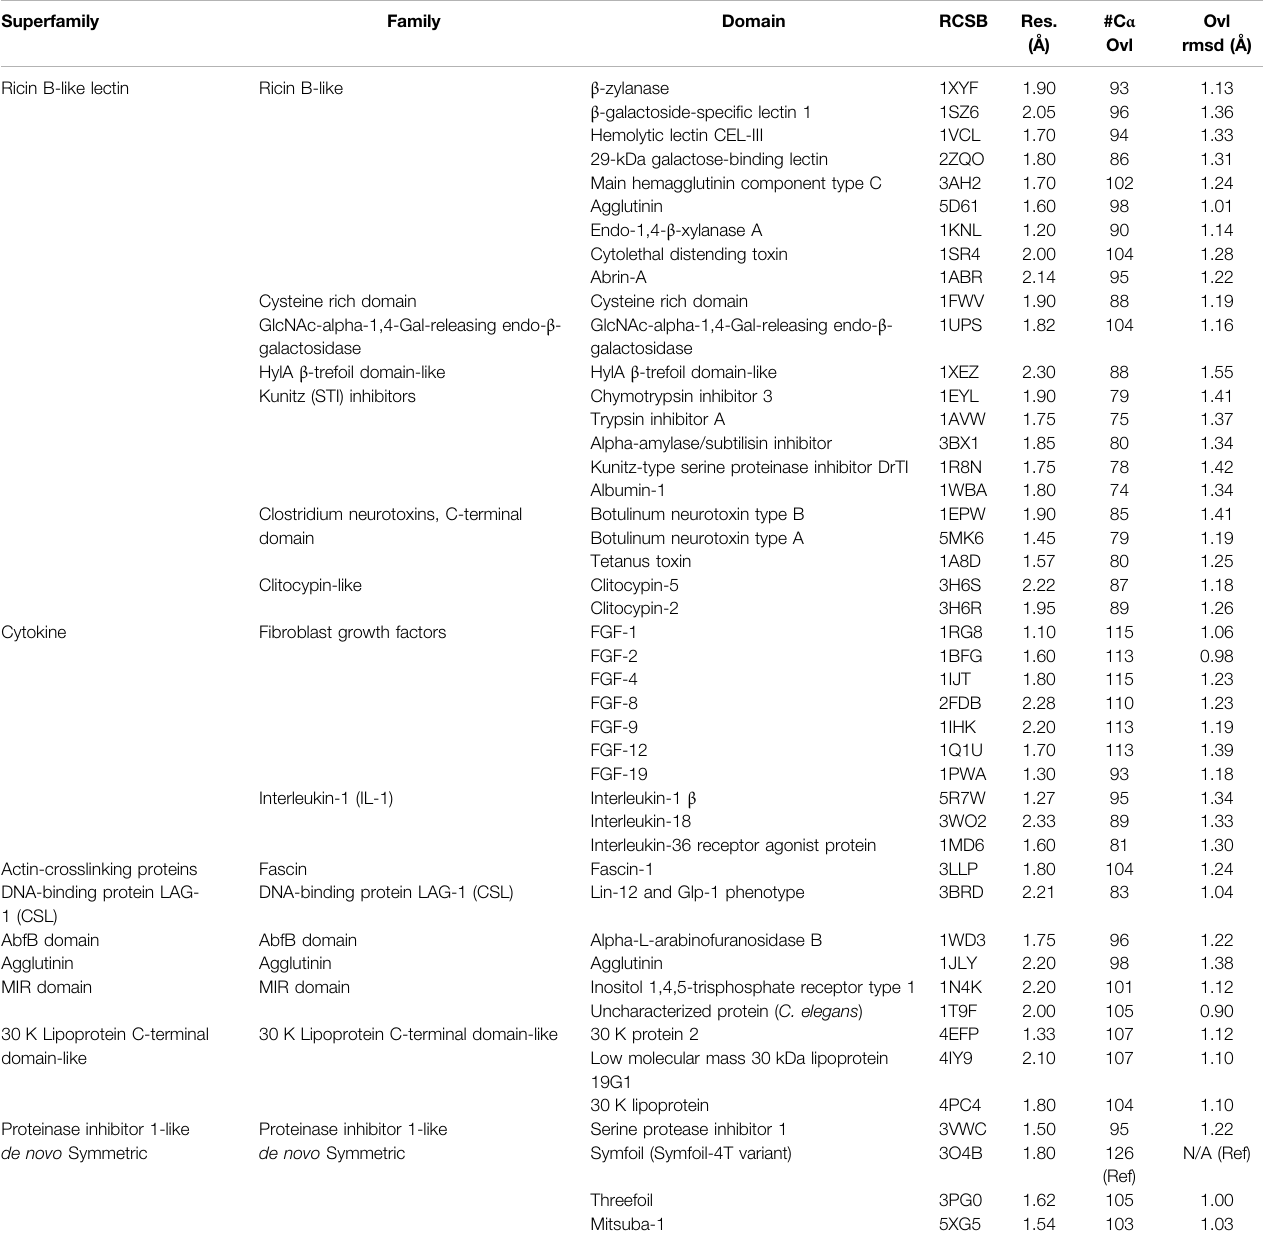
TABLE 1 | β -trefoil superfamily and structures utilized in characterization of secondary structure heterogeneity. The overlay statistics with Symfoil-4T (RCSB 3O4B) are also provided. Superfamily